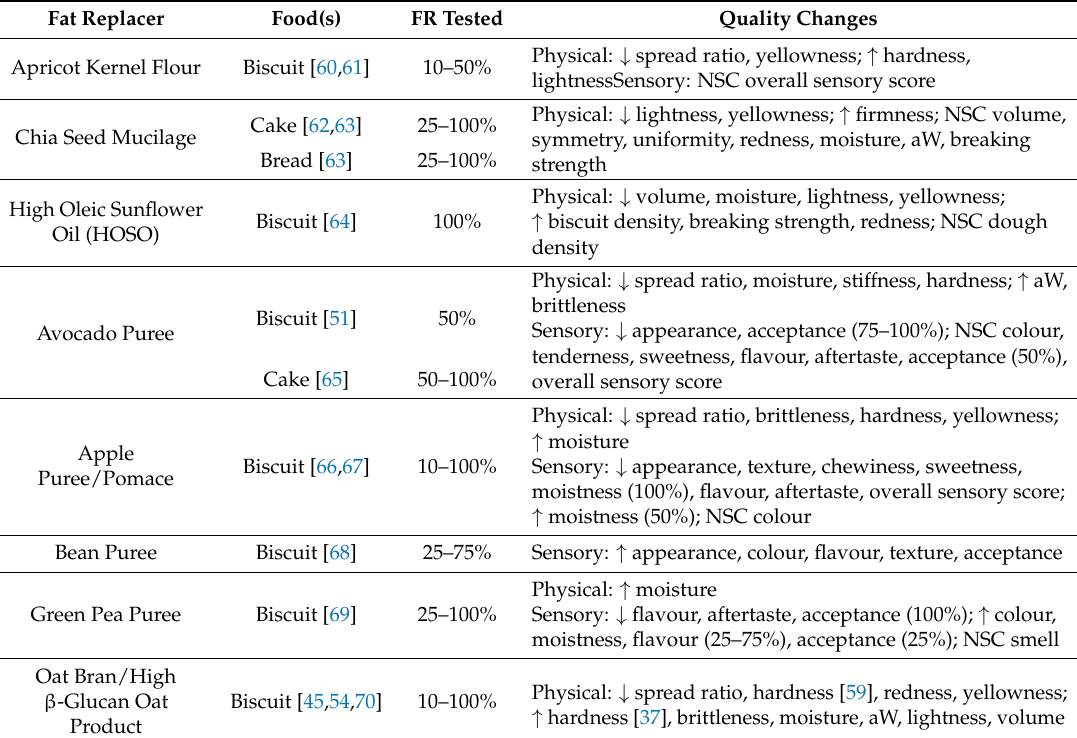
Table 3. Summary of quality changes of whole food fat replacers in baked food